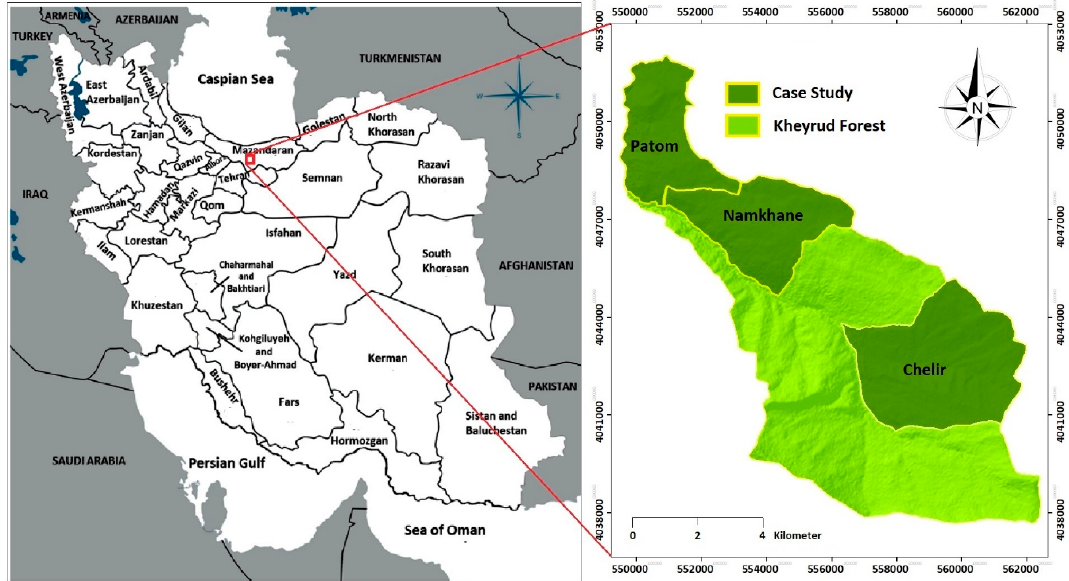
Figure 1. Location of the Chelir, Namkhane, and Patom study sites within the Kheyrud Forest of Mazandran Province in northern Iran. This forest is part of the Caspian Hyrcanian